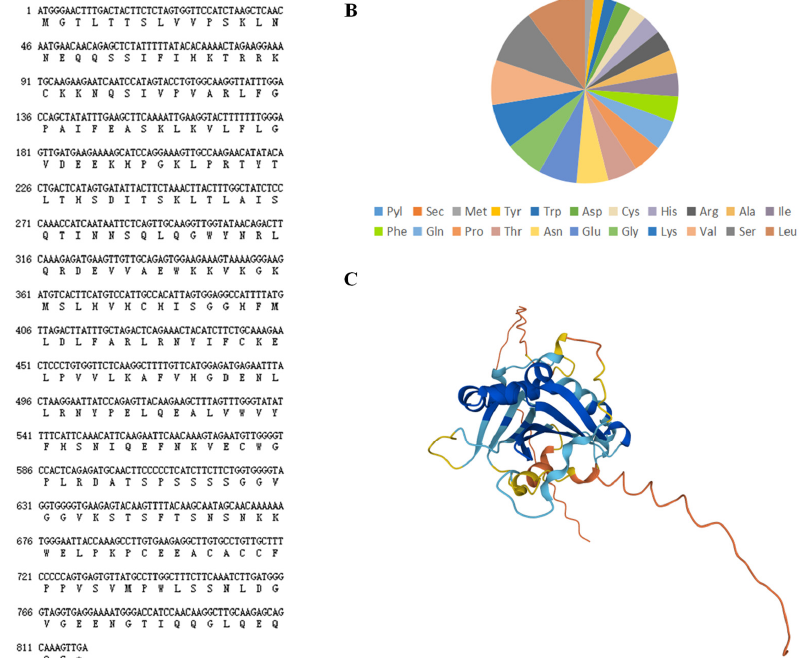
Figure 2. Sequence assays of SlSGR2: ( A ) nucleotide and gene sequences of SlSGR2 coding regions; ( B ) amino acid composition of SlSGR2; ( C ) tertiary structure of SlSGR2 protein.